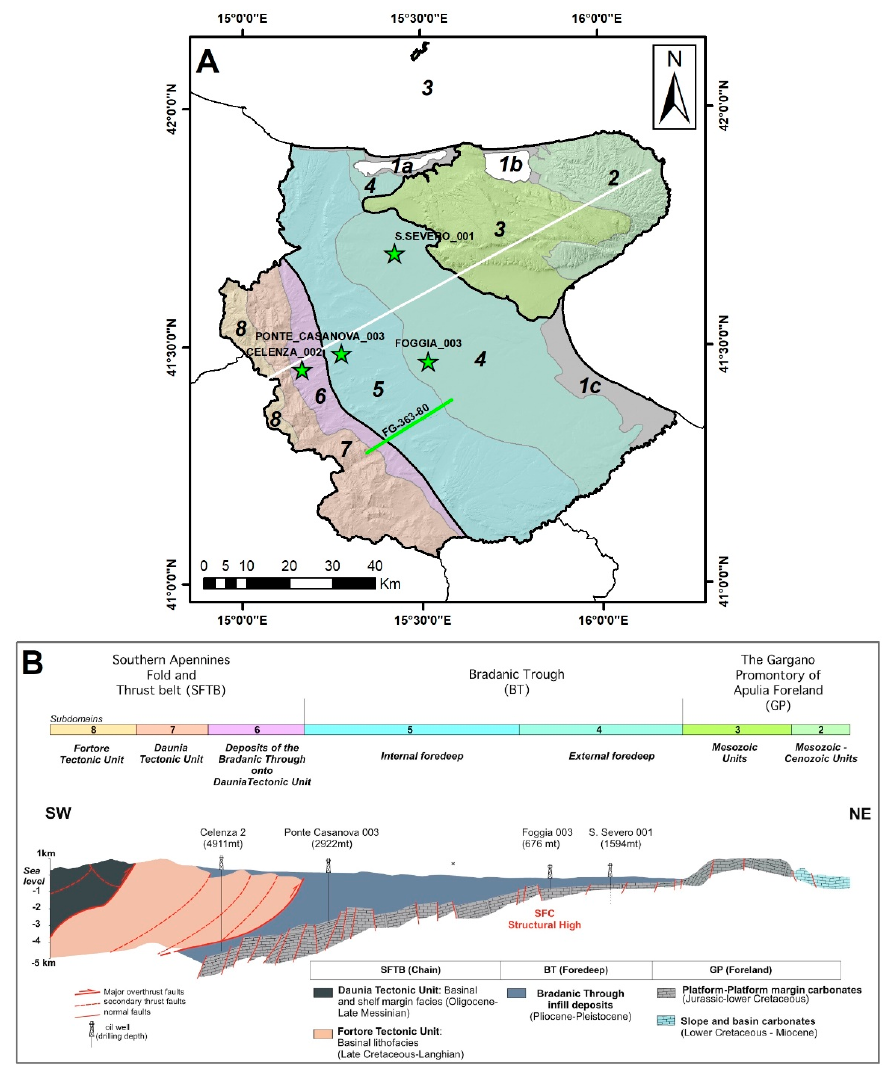
Figure 3. ( A ) Map of the morphostructural domains (delimited by thick black lines) and subdomains (colored zones delimited by gray lines) constituting the study area. In particular, subdomains 1b, 2 and 3 belong to the Gargano Promontory of Apulia Foreland; subdomains 1a, 1c, 4 and 5 belong to the Bradanic Trough; subdomains 6, 7 and 8 belong to the Southern Apennines Fold and Thrust belt. Green stars and green lines represent the ViDEPI Project investigations (Figure 2) used to constrain the schematic geological cross-section shown in panel B, whose trace is represented by the white line. Thin black lines represent the Italian regional administrative limits. ( B ) Schematic geological cross-section representing the overall configuration of the study area (modified from [16,27]).